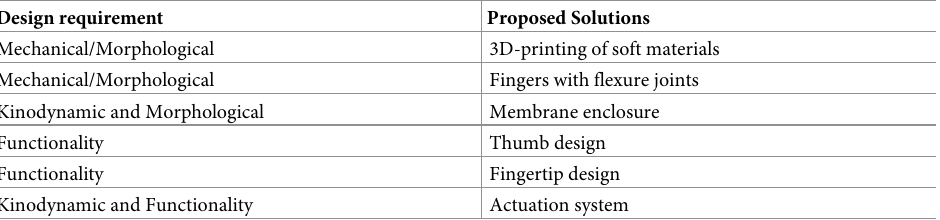
Table 2. Proposed solutions for different design requirements.